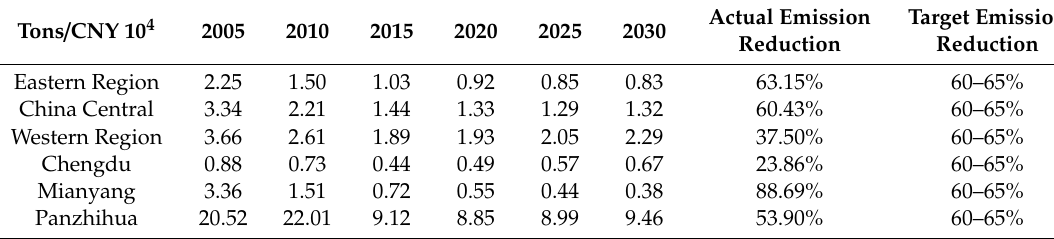
Table 4. Forecast of the carbon emission